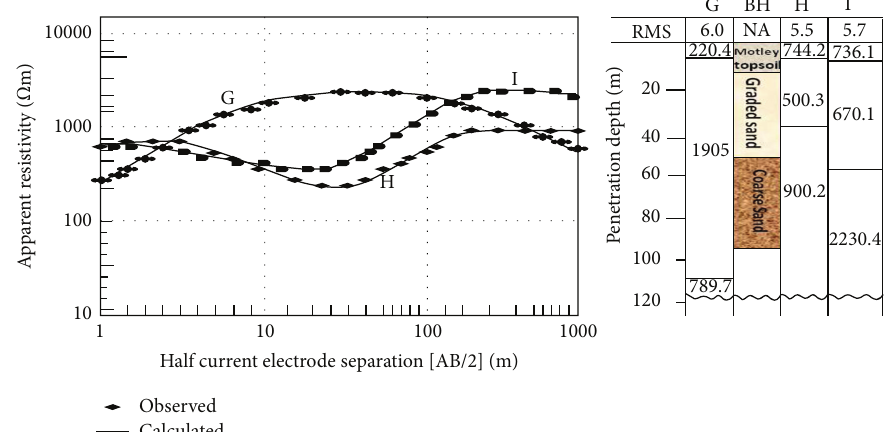
Figure 4: Typical VES curves and modelled results obtained along C-C 1 profile (G Akwa Savings & Loans H Fire service station and I Theological